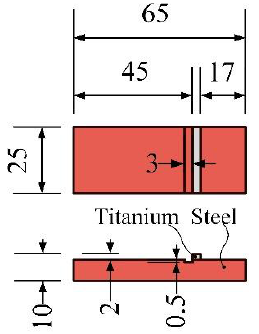
Figure 4. Shear test